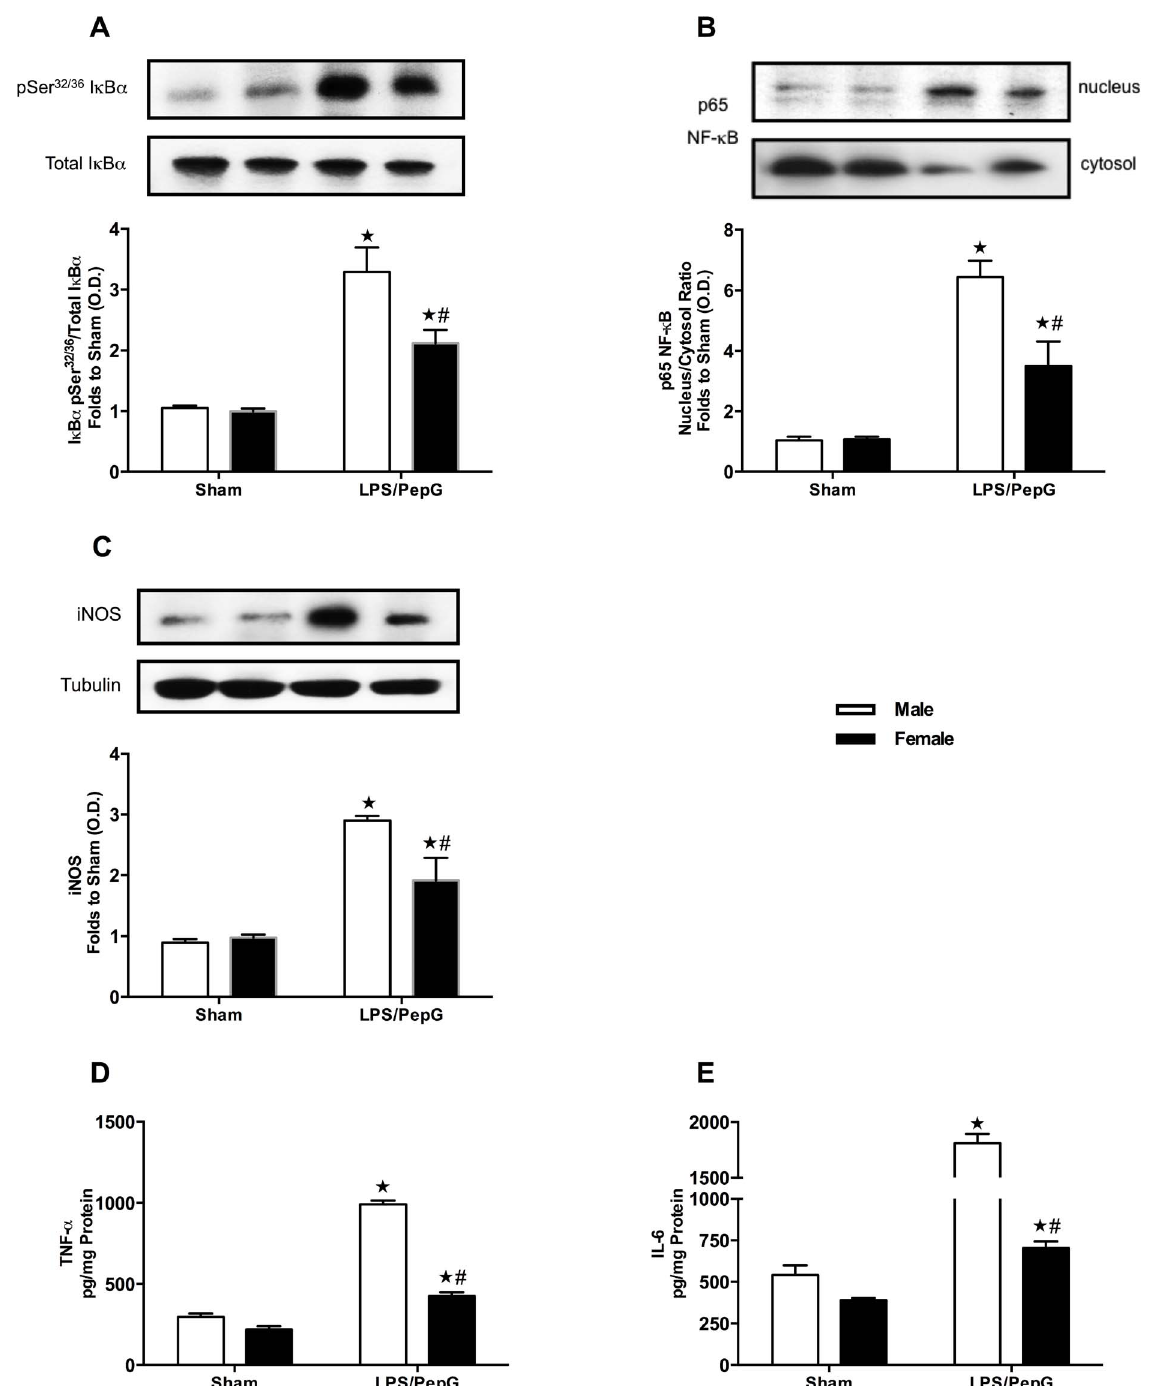
Figure 3. Gender dimorphism of the phosphorylation of I k B a , nuclear translocation of the p65 NF- k B subunit, expression of iNOS, TNF- a and IL-6 in the hearts of mice subjected to LPS (3 mg/kg)/PepG (0.1 mg/kg) co-administration. Male or female mice received either LPS (3 mg/kg)/PepG (0.1 mg/kg) or PBS. Signalling events in heart tissue were assessed at 18 hours. Densitometric analysis of the bands is expressed as relative optical density (O.D.) of ( A ) phosphorylated I k B a (pSer 32/36 ) corrected for the corresponding total I k B a content and normalized using the related sham band; ( B ) NF- k B p65 subunit levels in both, cytosolic and nuclear fractions expressed as a nucleus/cytosol ratio normalized using the related sham bands; ( C ) iNOS expression corrected for the corresponding tubulin band, and ( D ) TNF- a expression in heart tissue of mice subjected to LPS/PepG; ( E ) IL-6 expression in heart tissue of mice subjected to LPS/PepG. Each analysis ( A – E ) is from a single experiment and is representative of three to four separate experiments. Data are expressed as means 6 SEM for n number of observations. w P , 0.05 versus the respective sham group, # P , 0.05 versus male LPS/PepG group.